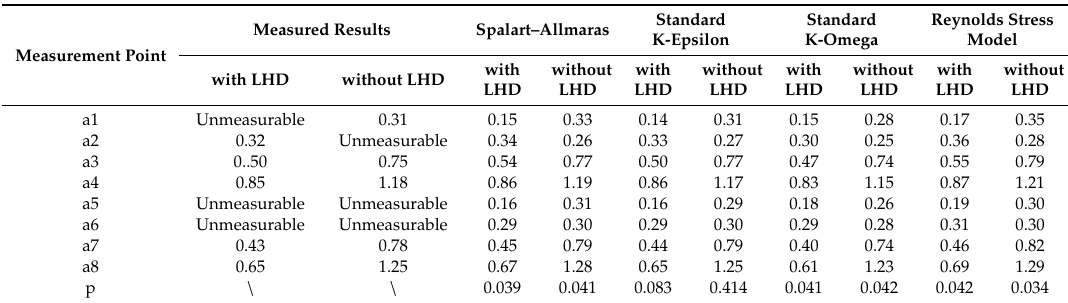
Table 5. Comparison between the measurement data of airflow velocity and the simulation data for various models.